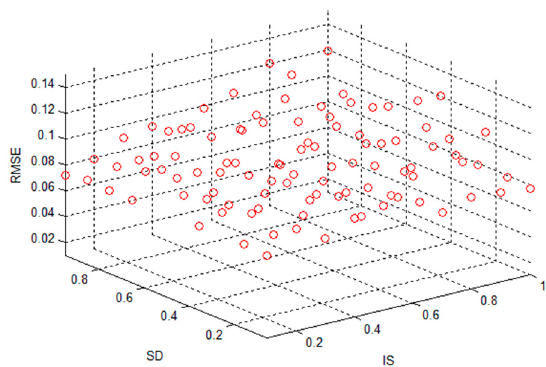
Figure 11. Standard deviation RMSE when input scale IS and reserve pool sparseness SD change.